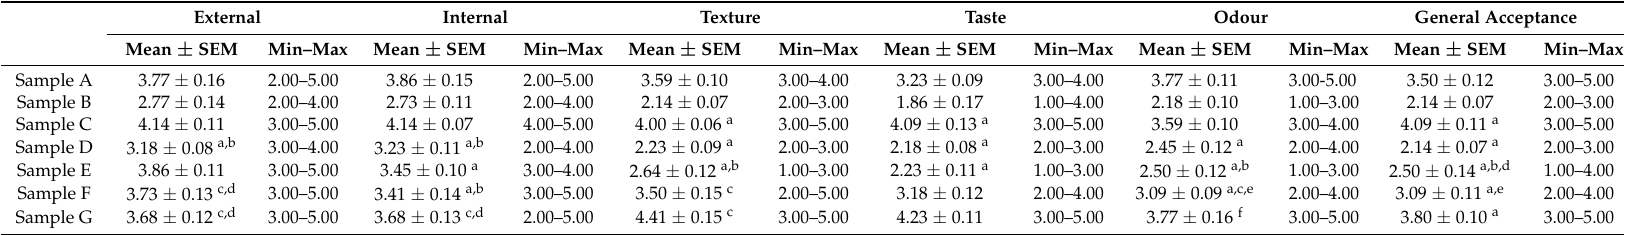
Table 5. Panelists’ sensorial